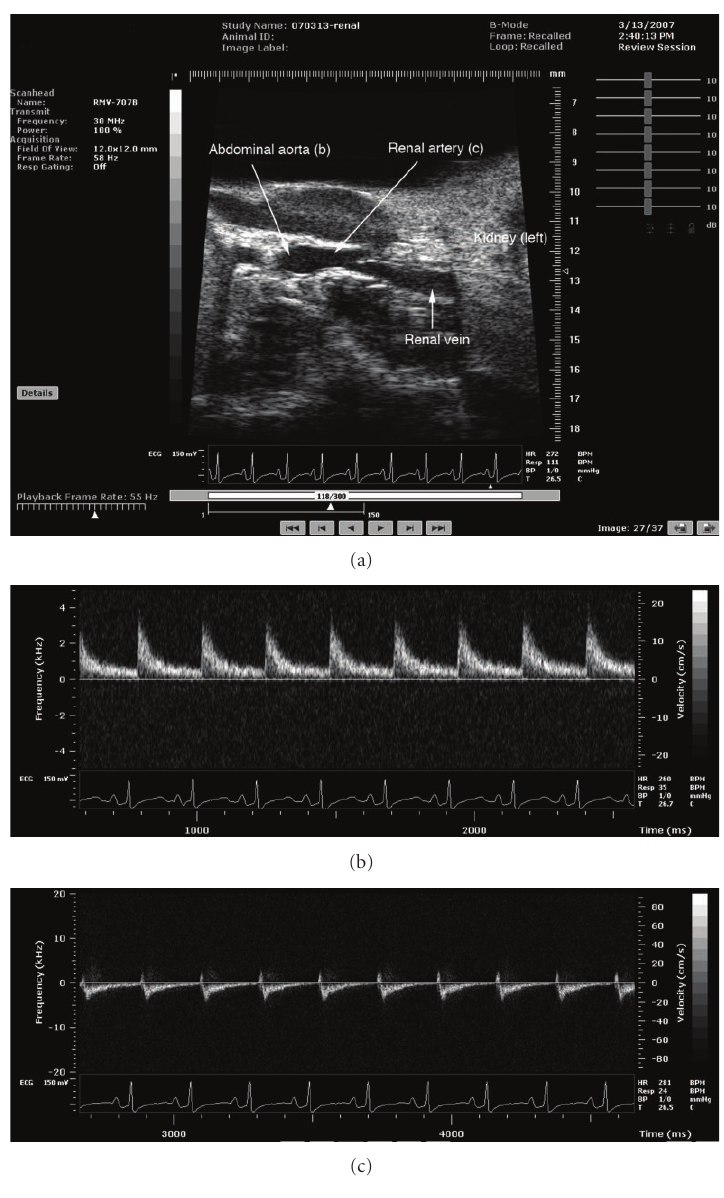
Figure 5: Ultrasound microimaging around the left kidney (a) and Doppler flow measurement at the abdominal aorta (b) and renal artery (c). Appropriate positions of the abdominal aorta, renal artery, and renal vein observed with the ultrasound imaging device are indicated in (a). The blood flow of the abdominal aorta indicated by the arrow in (a) is shown in (b). The blood flow of the renal artery indicated by the arrow in (a) is shown in (c). Doppler flow data show unidirectional (b) and oscillating (c) flow patterns in the abdominal aorta and renal artery, respectively. Note that the waveform of the renal artery indicated in (c) is the opposite of that for the abdominal aorta in (b) because of the position of the ultrasound